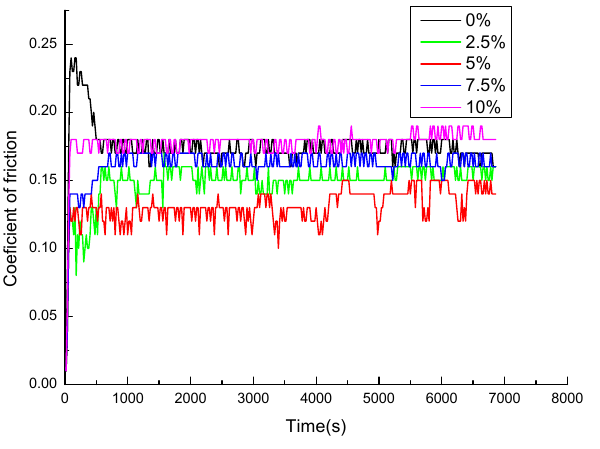
Figure 6: Variation in the time-dependent friction coeflcients of PEEK/SBF composites